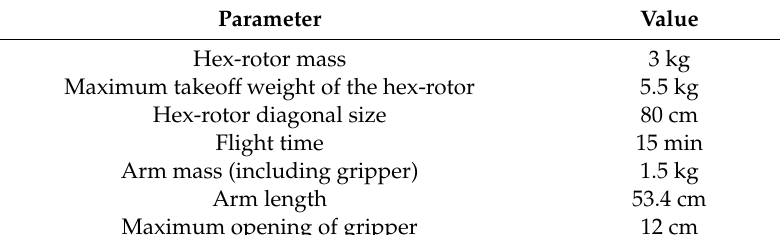
Figure 4. Experimental platform. Table 1. Parameters of aerial manipulator.